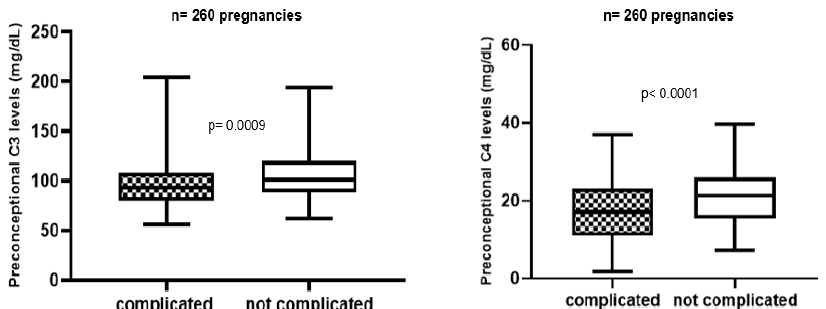
Figure 1. Preconception complement level in complicated vs. not complicated pregnancies.